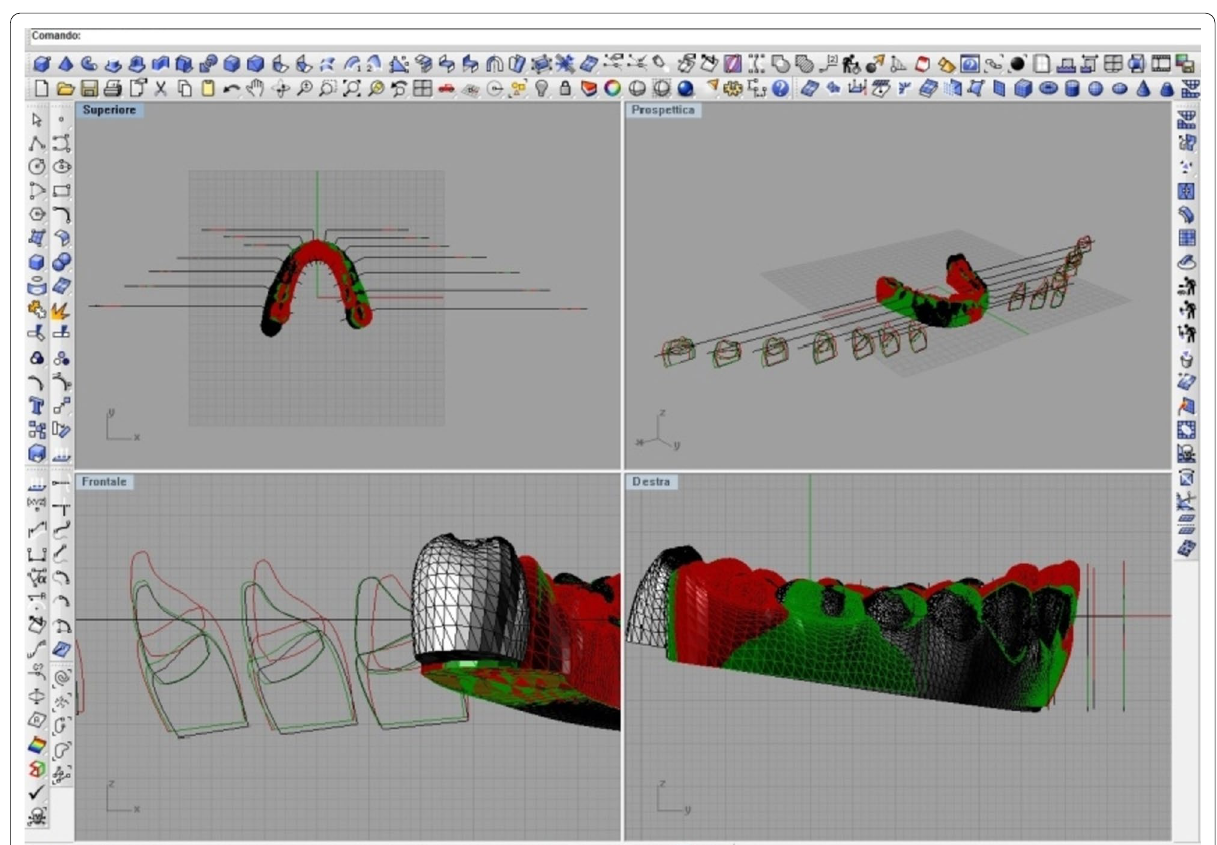
Fig. 3 Three models overlapping and sections for every single tooth from an occlusal, perspective, frontal and sagittal point of view with Rhinoceros